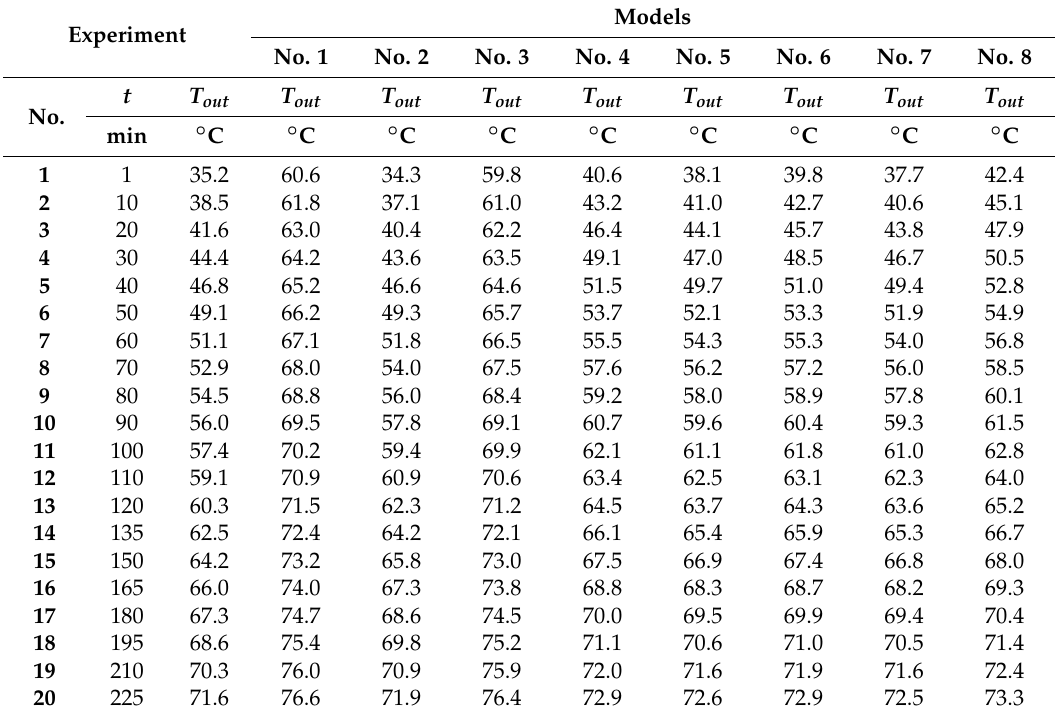
Table 3. Experiment results for the airflow of 0.0050 m 3 /s.